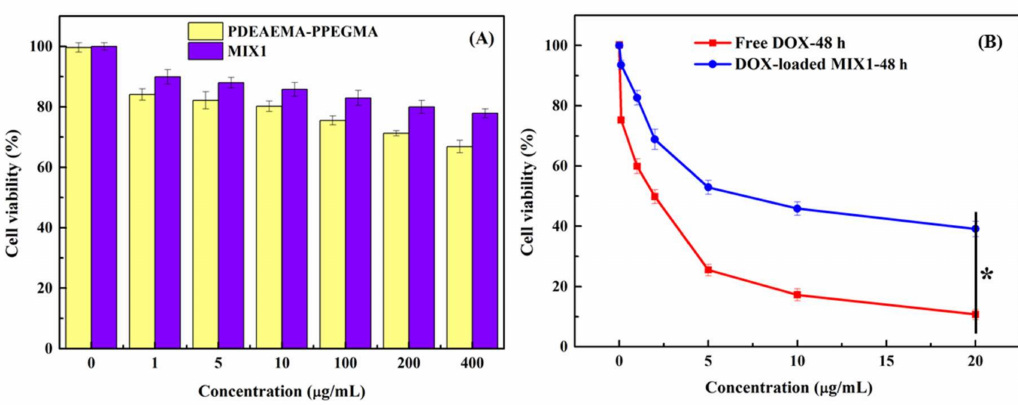
Figure 8. In vitro cytotoxicity of blank MIX1 and polymer PDEAEMA 28.8 -PPEGMA 12.4 ( A ), free DOX and DOX-loaded mixed micelles ( B ) and in HepG2 cells. * p <